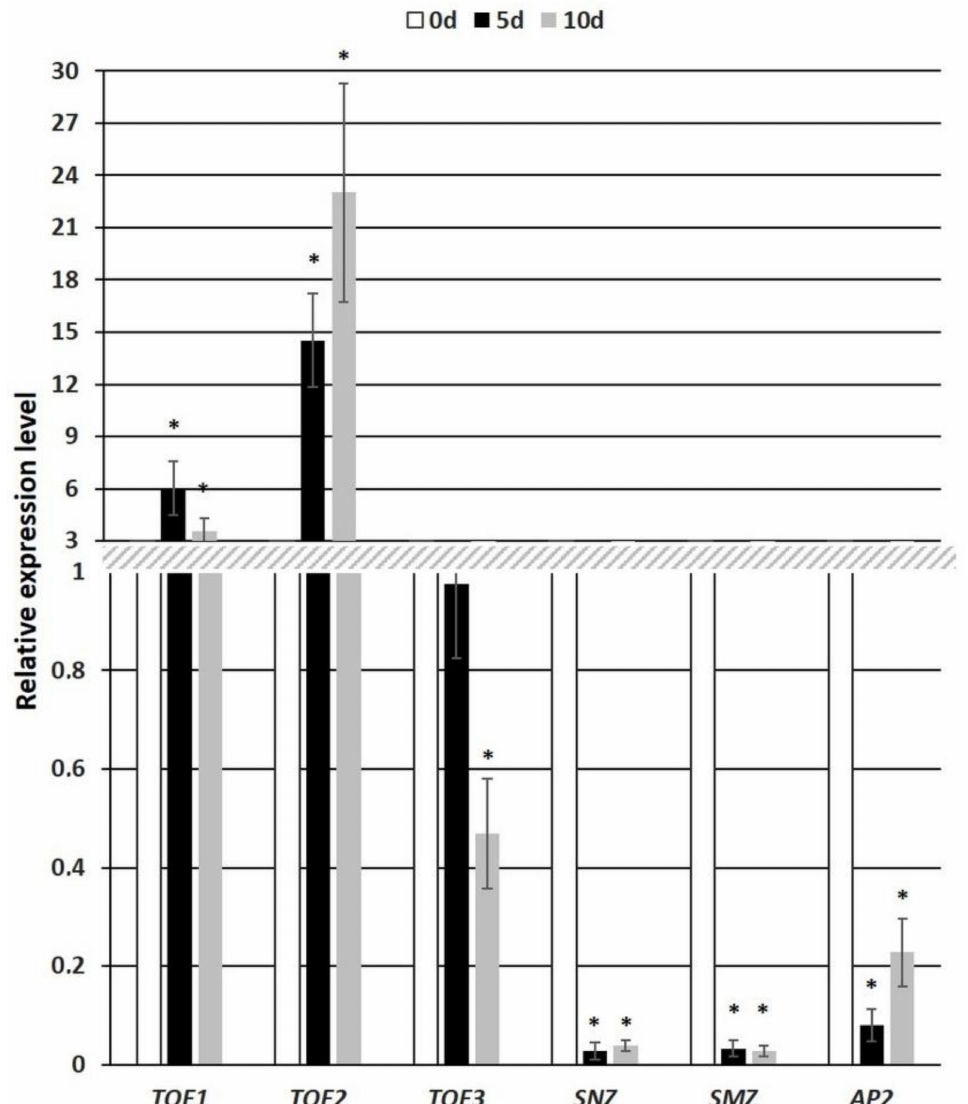
Figure 2. The expression level of the candidate miR172 targets, including TOE1 , TOE2 , TOE3 , SNZ , SMZ and AP2 in the embryogenic culture of Col-0. The relative transcript level was normalized to an internal control ( At4g27090 ) and calibrated to 0 d of the culture. * values significantly different from the freshly isolated 0 d explants ( p < 0.05; n = 3 ±